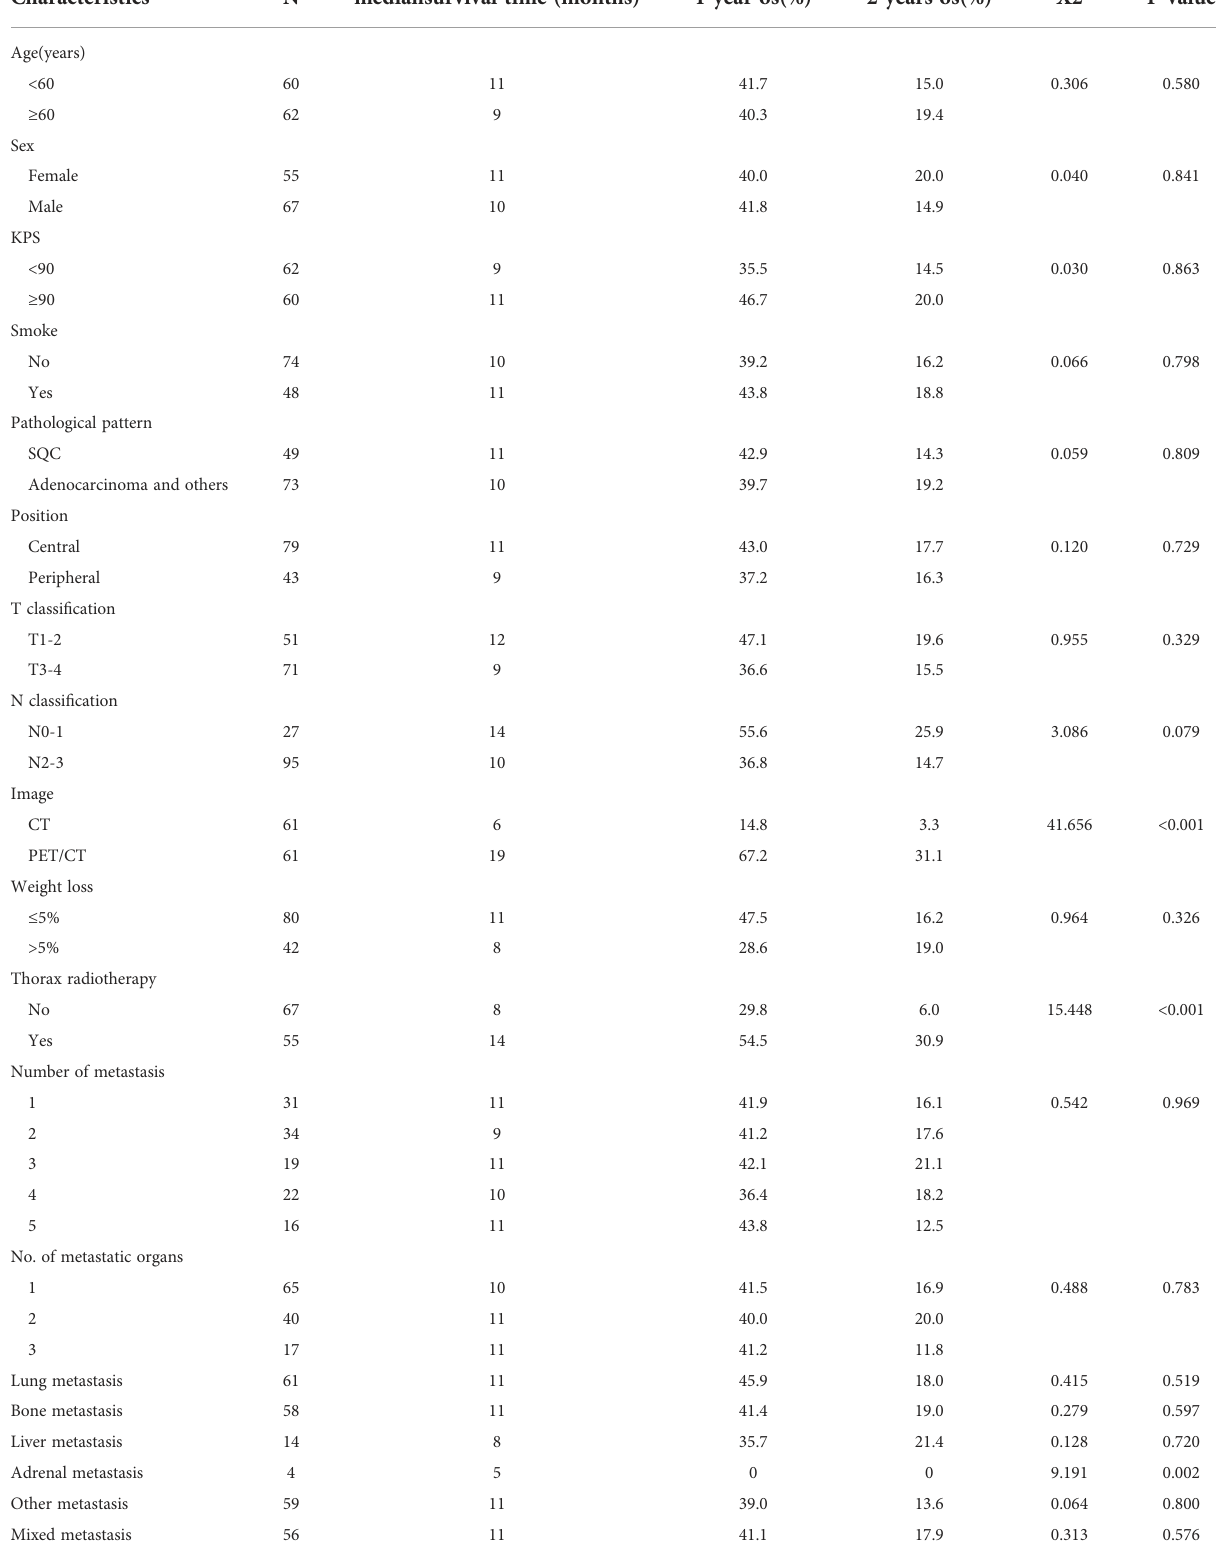
TABLE 3 Univariate analysis between prognostic factors and overall survival (After PSM).